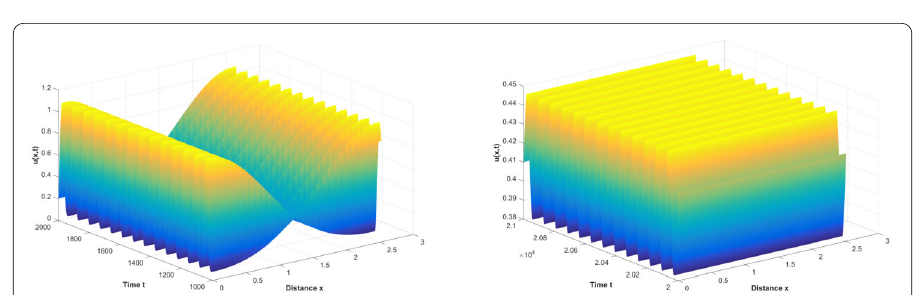
Figure 6 Numerical simulations for prey population with β = 0.5 τ = 22. (Left: model (1.4). Right: model